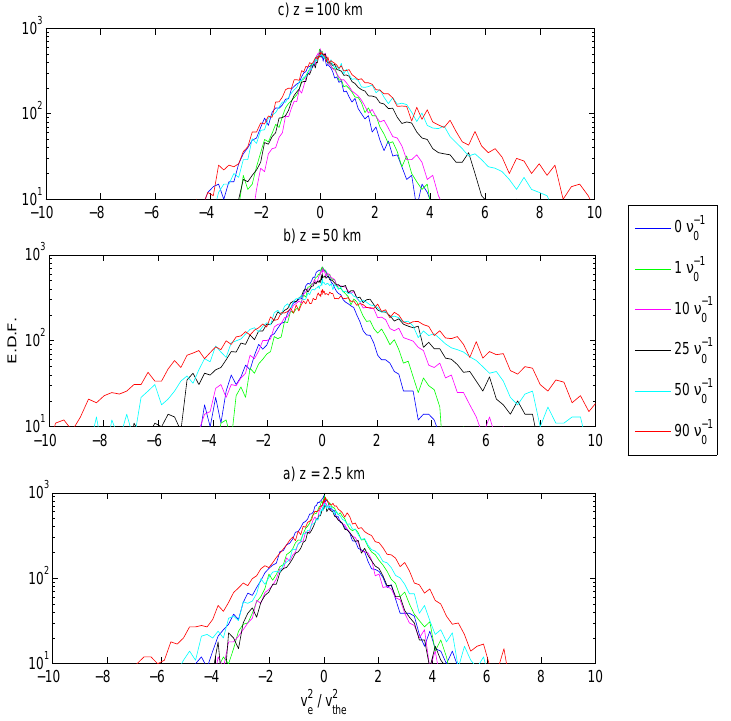
Fig. 6. Velocity distribution functions as a function of normalized squared velocity. The distribution functions corresponding to three different altitudes (from the bottom to the top panel respectively 2.5, 50 and 100 km) are shown for different times (0, 1, 10, 25, 50 and 90 ν − 1 ) using different